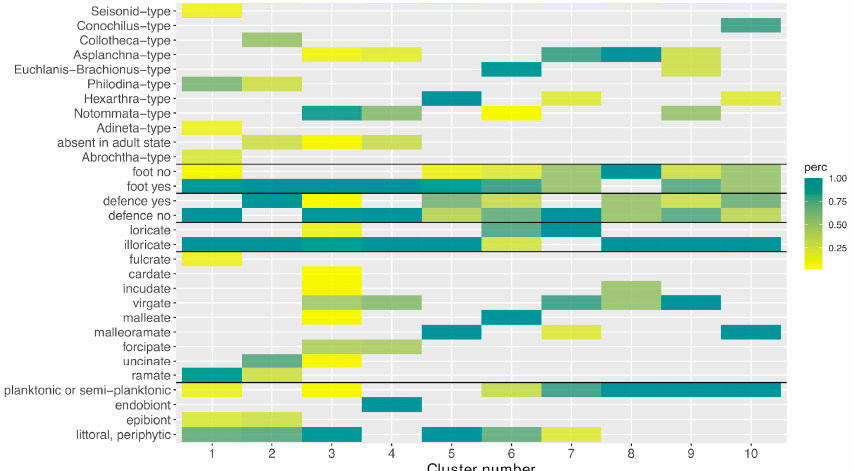
Figure 2. Heatmap of percent distribution of morphological traits within clusters 1 to 10 as assembled by hierarchical, divisive clustering. Black horizontal lines separate different traits; within traits, numbers sum up to 100%.